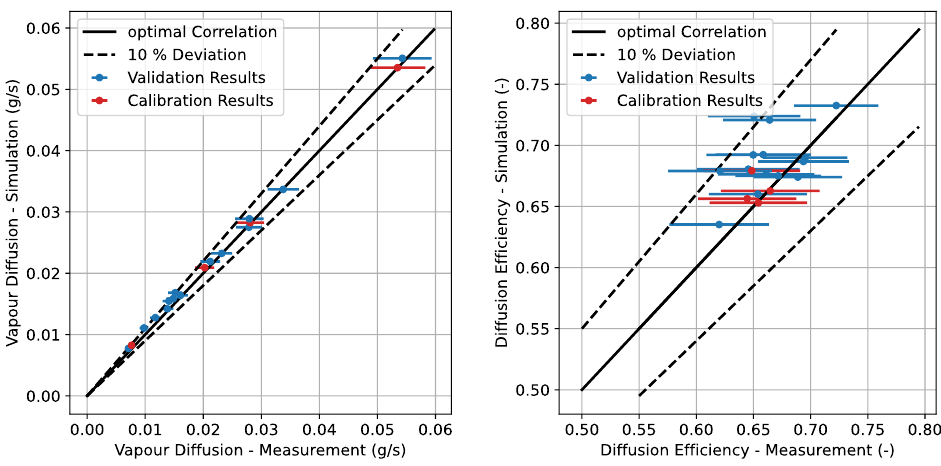
Figure 5. Comparison of measured and simulated vapour diffusion rates and mass transfer efficien- cies. The measurement data is plotted with error bars resembling the uncertainty of the